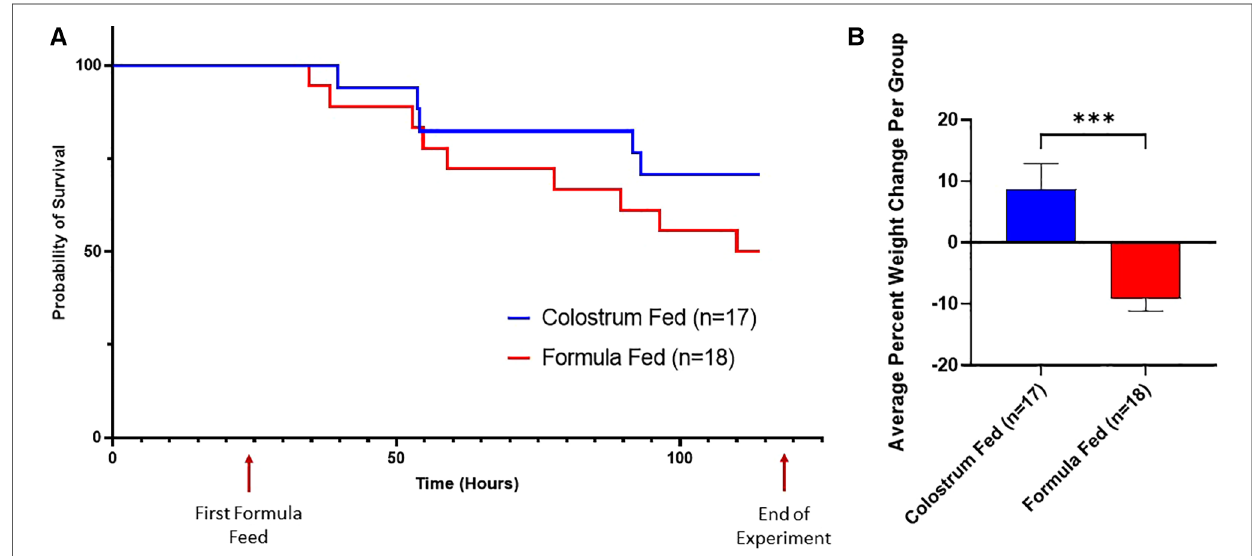
FIGURE 2 Survival curves and average percent weight change. ( A ) Survival Curves. These survival curves depict all-cause mortality (NEC plus non-NEC deaths) over the course of the experiment. ( B ) Weight Change. The percent weight change per piglet was averaged for each group. Variability of sample means was reported as a standard error of the mean (SEM) and statistical signi fi cance level was set to α =0.05. Statistical analysis was carried out using the Mann – Whitney U -test (*** p